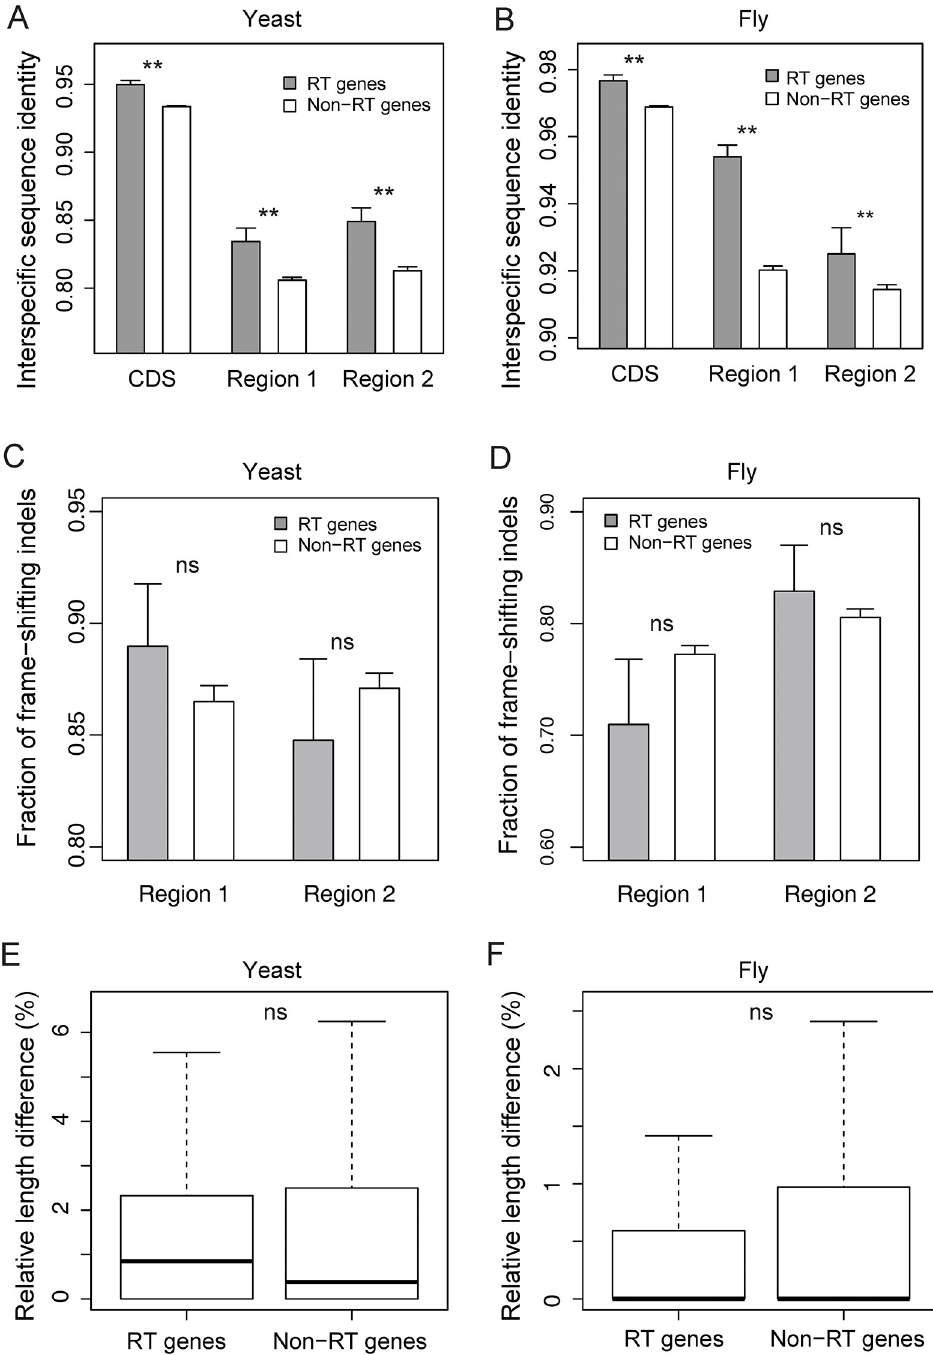
Fig 3. Conservations of various regions in read-through (RT) and non-read-through (non-RT) genes. The read- through genes used are from [8, 9], whereas all other genes are treated as non-read-through genes. A total of 147 read- through and 4,225 non-read-through yeast genes and 233 read-through and 8,367 non-read-through fly genes are considered. Region 1 refers to the transcript segment between the canonical stop codon and the following in-frame stop codon, whereas region 2 refers to the transcript segment between the first and second in-frame stop codon after the canonical stop codon. CDS, coding sequence. ( A - B ) Sequence conservation of coding region, region 1, and region 2 between S . cerevisiae and S . paradoxus ( A ) or between D . melanogaster and D . simulans ( B ) for read-through and non-read-through genes. ( C - D ) Fractions of frame-shifting indels in regions 1 and 2 of read-through and non-read- through genes, based on a comparison between the two yeasts ( C ) or two fruit flies ( D ). In (A)-(D), error bars show